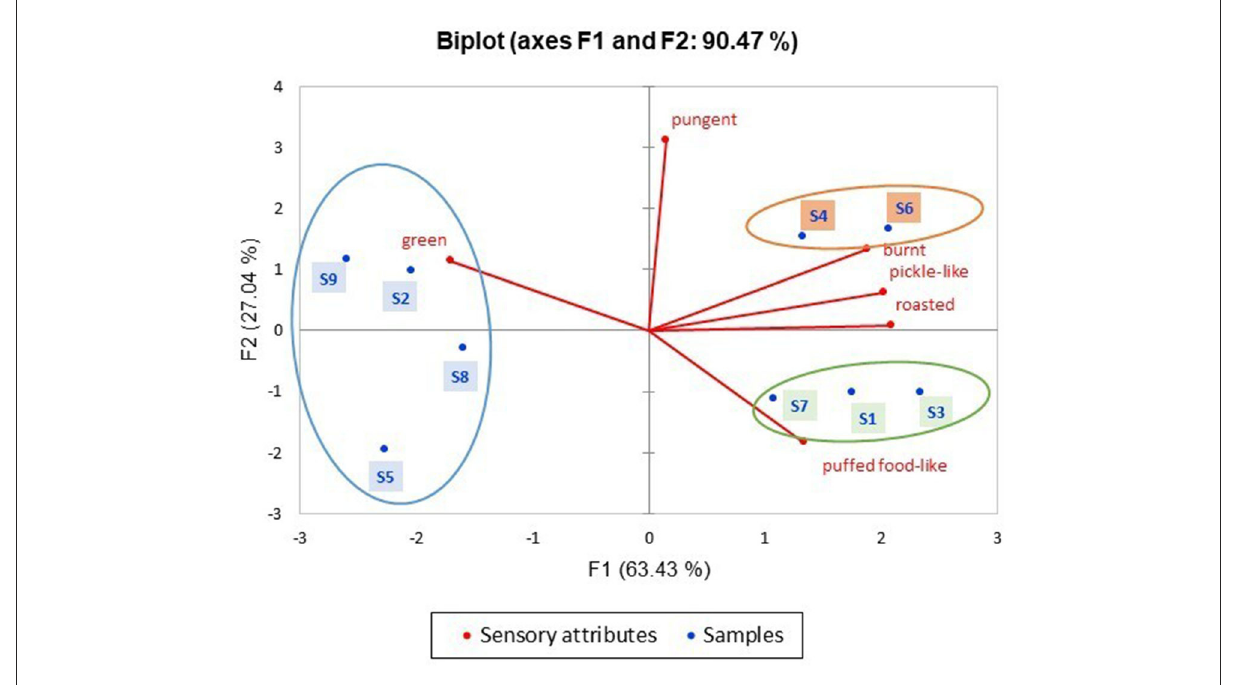
FIGURE1 Principal component analysis diagrams of the nine fragrant rapeseed